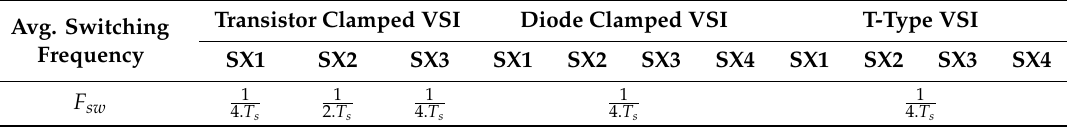
Table 3. Average switching frequency of the transistor clamped, diode clamped and T-type VSI. Avg. Switching